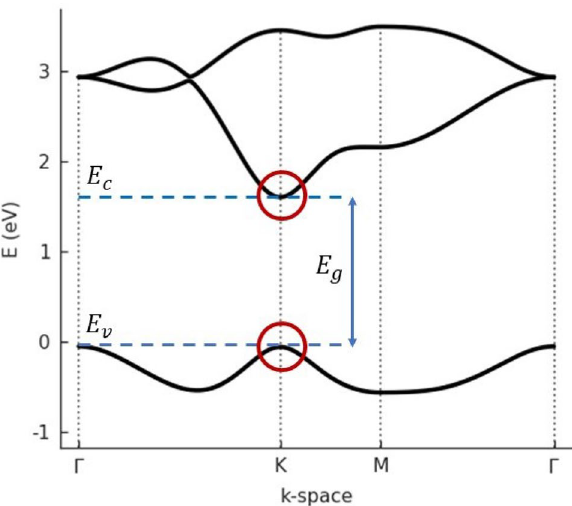
Figure 2. Band structure of monolayer MoS 2 calculated within three-band tight-binding model 43 . Conduction (valence) band edge is given by E c ( E v ) . The free particle band gap E g = 1.6 eV. The effective masses at K-point are m e = 0.60, m h = 0.54 in units of free electron mass. The reduced mass µ = 0.28 . Red circles denote regions where the effective mass approximation is used. The band structure has been calculated with the help of Pybinding Python package 44